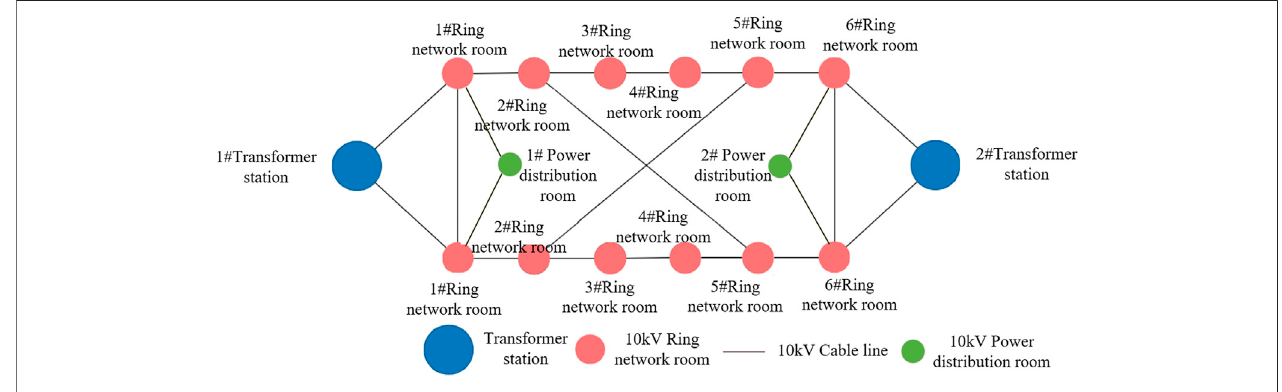
FIGURE 6 | Diamond-shaped distribution network